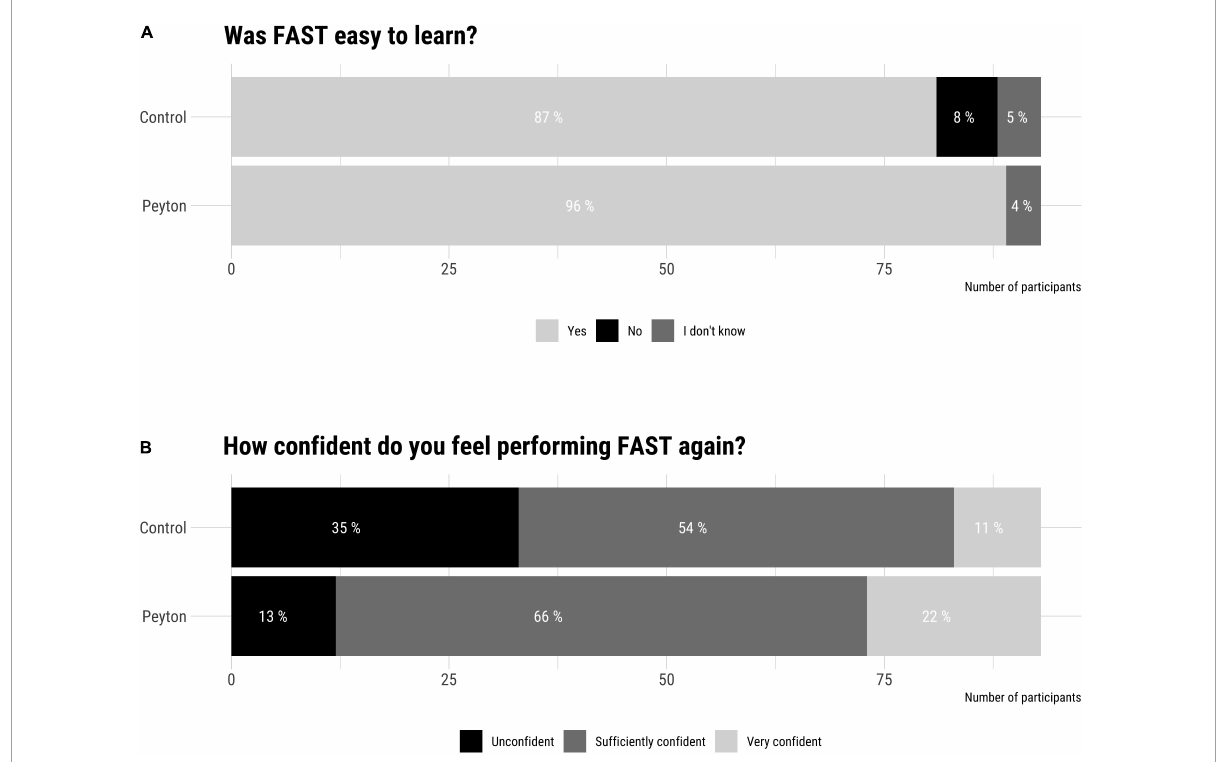
FIGURE6 Post-participation survey results. Difficulty learning (A) and self-confidence to perform (B) Fiberoptic-assisted tracheoscopy